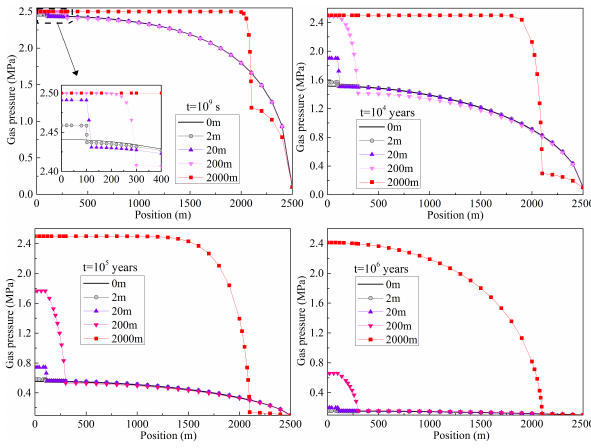
Figure 6. Gas distribution with various lengths of the low- permeability zone with permeability 0.1% of the normal coal seam permeability.